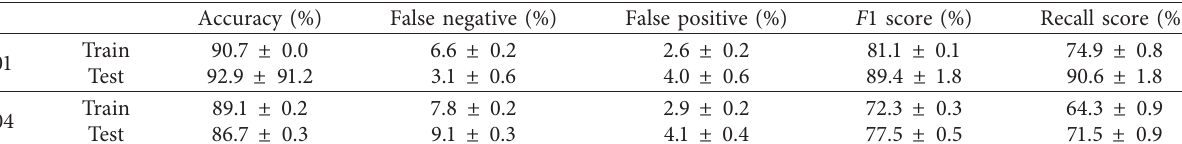
Table 4: Classification metrics for random forest models with a 95% confidence